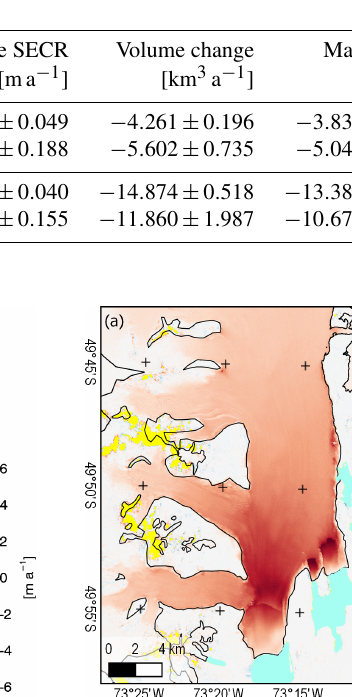
Table 1. Results over NPI and SPI for the two epochs. The reported area refers to the beginning of the epoch, the coverage of the SECR map is also reported. Subaqueous ice changes are not included.